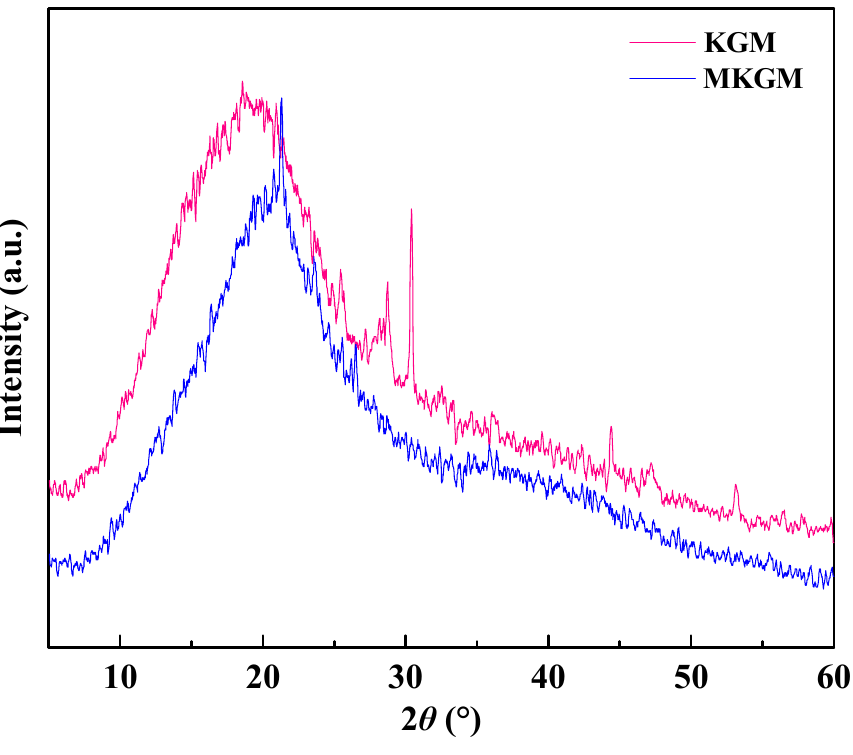
Figure 3. XRD patterns of KGM and MKGM.